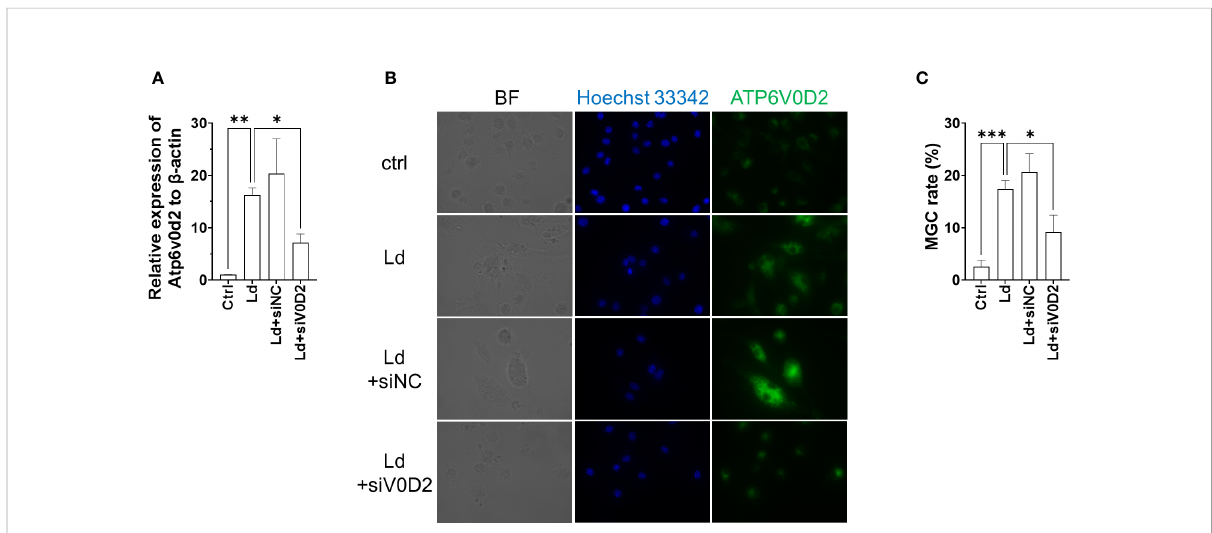
FIGURE 6 Knockdown of ATP6V0D2 reduced MGC formation in Leishmania donovani -infected BMDMs. (A) BMDMs were transfected with either siRNA of ATP6V0D2 or random negative control 24 h before L. donovani infection. Relative expressions of Atp6v0d2 mRNA to b -actin mRNA were quanti fi ed by qPCR. (B) ATP6V0D2 was stained with anti-ATP6V0D2 antibody and Hoechst 33342. (C) Over 300 cells for each experiment were counted for calculating MGC rates. Means ± SD of three independent experiments are shown. * P < 0.05, ** P < 0.01, *** P < 0.001 by one-way ANOVA followed by Dunnett ’ s multiple comparisons